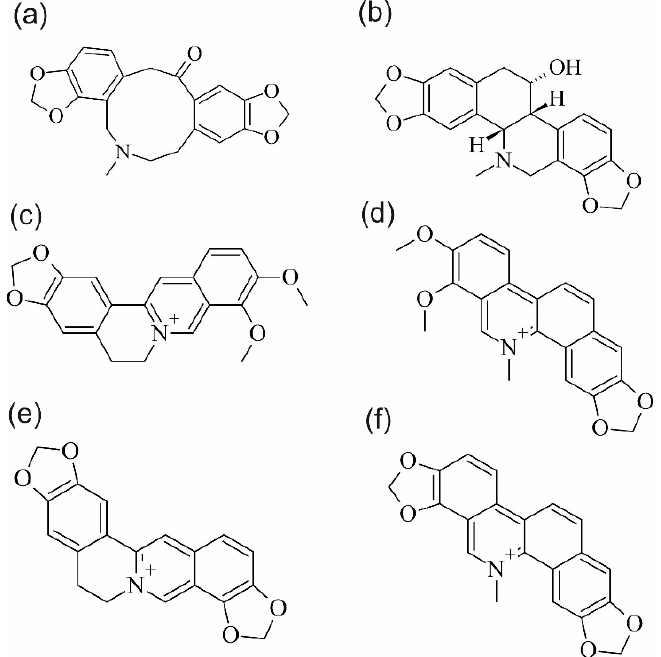
Figure 1. Chemical structures of major alkaloids in Chelidonium majus L.: ( a )—Protopine, ( b )—Chelidonine, ( c )—Berberine, ( d )—Chelerythrine, ( e )—Coptisine, and ( f )—Sanguinarine.